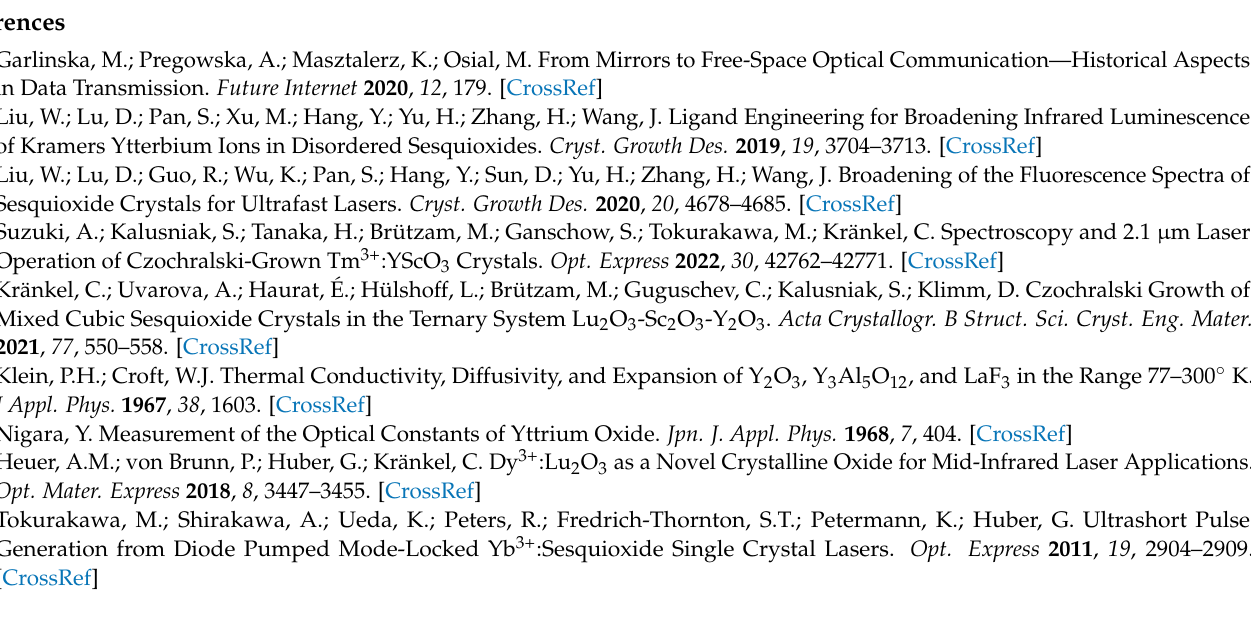
Figure S2: Micro-Raman spectra of YScO 3 , Nd 3+ :YScO 3 , and Tm 3+ :YScO 3 crystal fibers (black, red and blue ones,